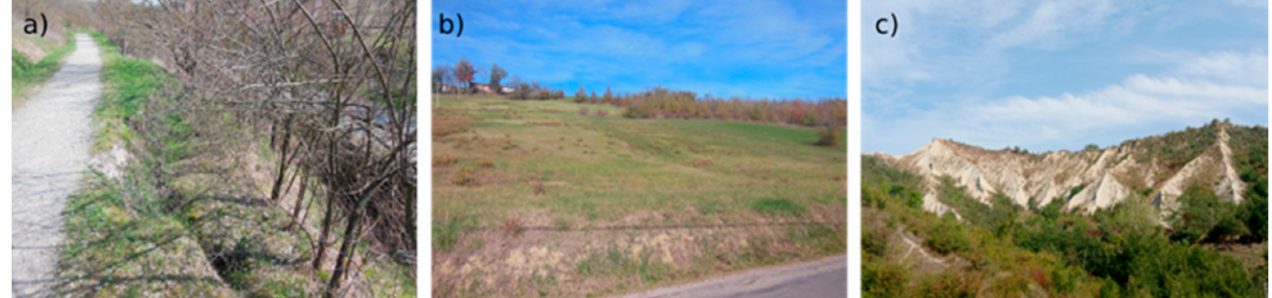
Figure 4. Main geological and geomorphological features of the study area: ( a ) Active landslide; ( b ) solifluction characteris- ing the Argille Azzurre Formation; ( c ) badland morphology characterising the Argille Azzurre Formation.